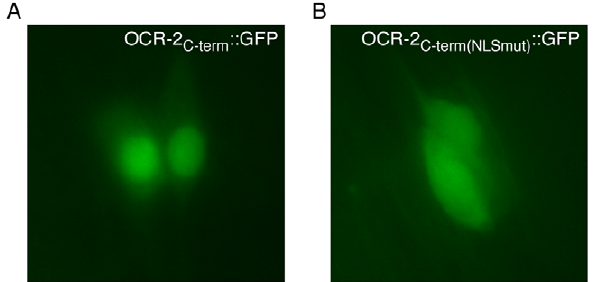
Figure 3. The cytoplasmic carboxy-terminal fragment of OCR-2 can utilize the NLS to localize to the nucleus. The entire carboxy- promoter ( ocr-2p::ocr-2 C-term ::gfp ). (A) The OCR-2 C-term ::GFP fusion was detected in the nucleus of ocr-2 expressing head and tail neurons in 91/ 91 transgenic animals examined. The PHA/PHB tail neurons are shown here. Furthermore, the basic residues of the NLS are required for the nuclear accumulation observed. (B) A GFP fusion to the carboxy- terminal tail in which the 6 previously identified essential lysine/ arginine residues had been mutated to alanine (Figure 2C) ( ocr-2p::ocr- 2 C-term(NLSmut) ::gfp ) resulted in a much less pronounced signal in the nucleus. The OCR-2 C-term(NLSmut) ::GFP signal was observed evenly distributed in the cytoplasm and nucleus of ocr-2 expressing neurons in 94/94 transgenic animals examined. The PHA/PHB tail neurons are shown here. Numbers represent the combined data of $ 3 independent transgenic lines for each construct.